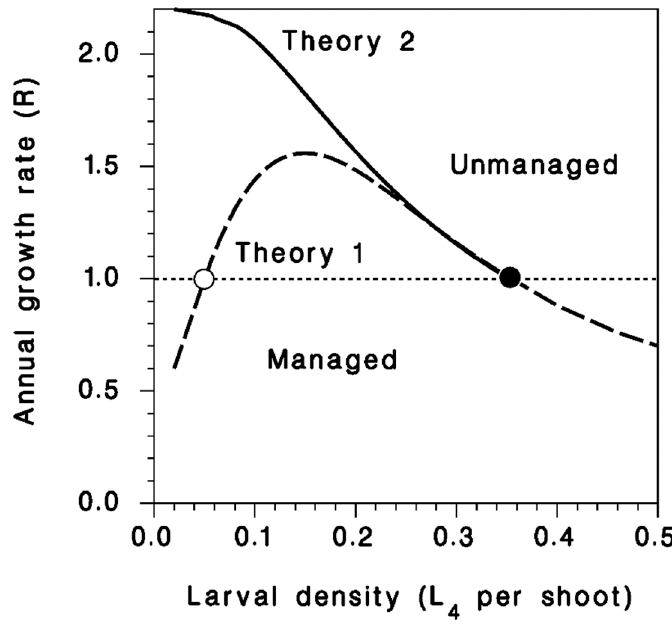
Figure 1. Population growth patterns hypothesized for managed and unmanaged incipient populations of spruce budworm, according to two contrasting theories of cycle initiation. Under Theory 1, management aims at maintaining populations below the threshold density (open circle) below which growth rates are < 1 and populations are kept in check by natural factors.